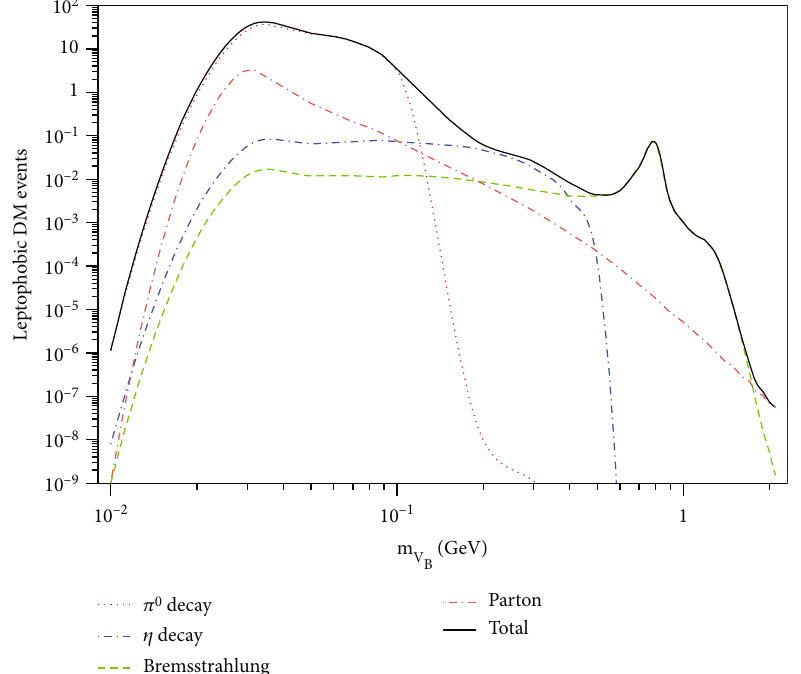
Figure 3: Dark matter-nucleon scattering event plot with the variation of mediator vector boson mass for all distinct channels. Here, m = 0 : 01 GeV, ε =0, α = 10 − 6 , and POT =1.1 × 10 21 . B